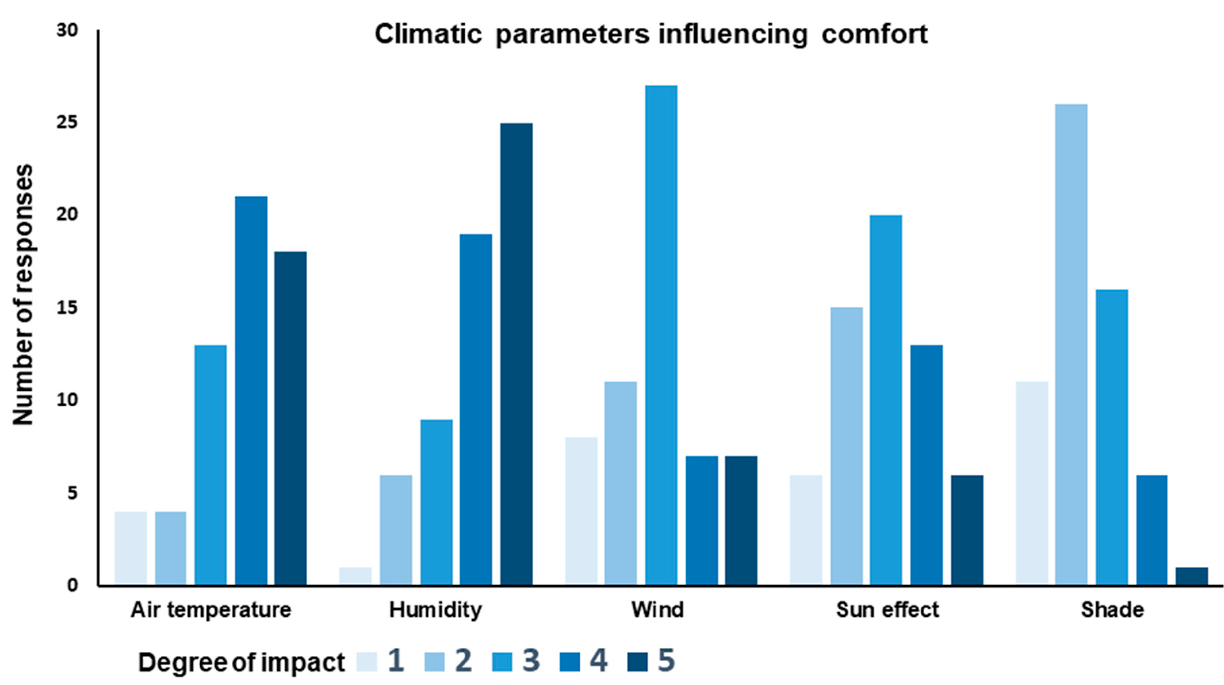
Figure A2. Parameters influencing daily comfort of people questioned in the Casbah of Algiers on a scale of 1 to 5.